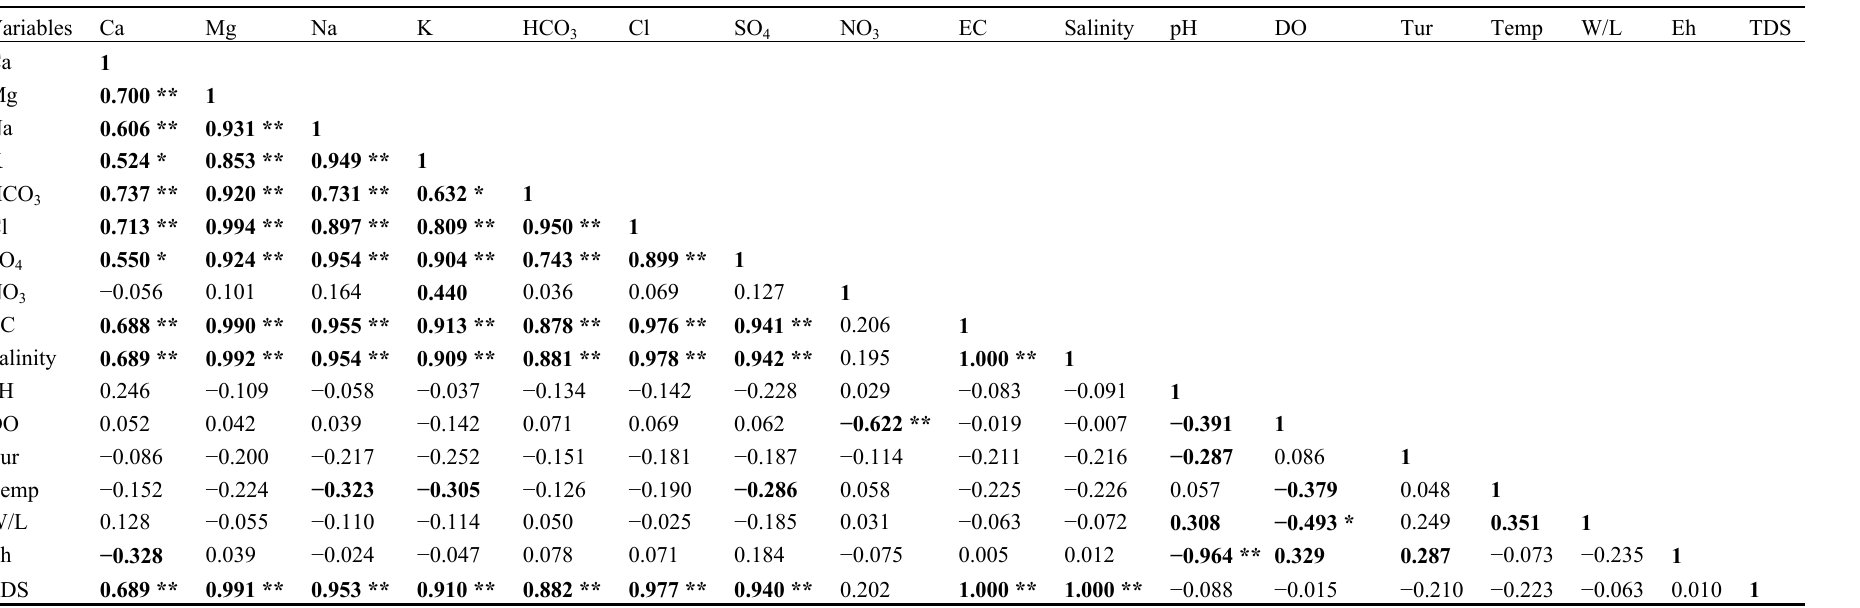
Table 3. Correlation matrix of the hydrochemical